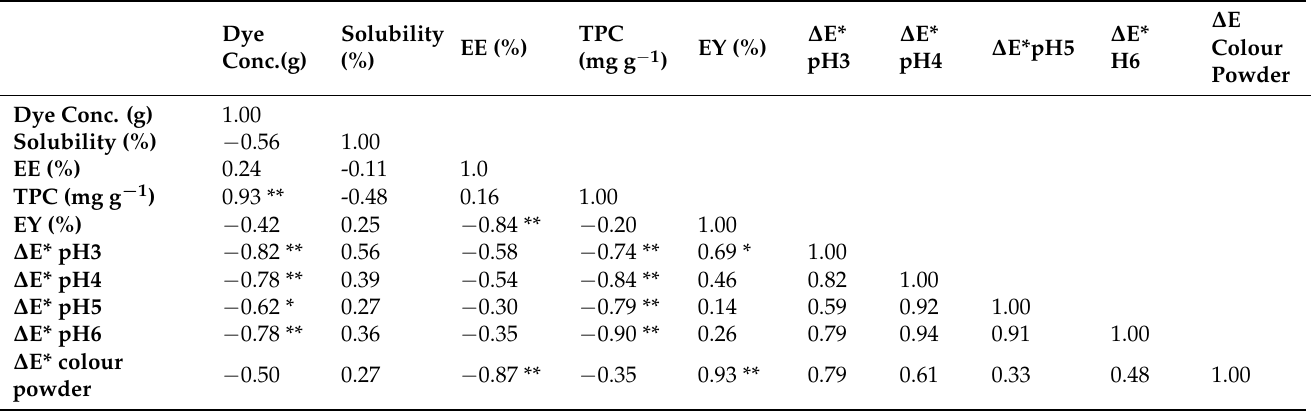
Table 4. Correlation coefficients between the data for the ten physicochemical parameters